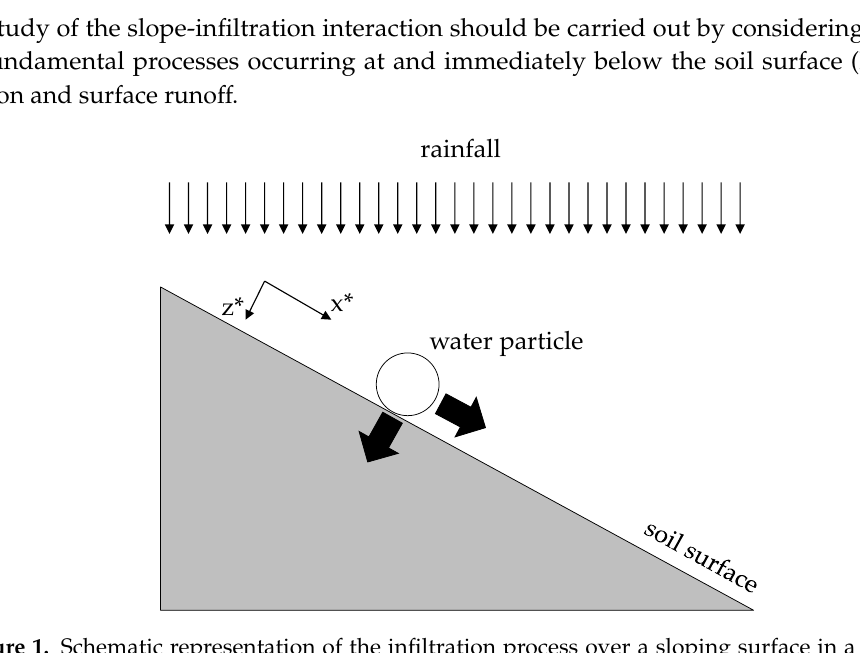
Figure 1. Schematic representation of the infiltration process over a sloping surface in a Cartesian coordinate system.